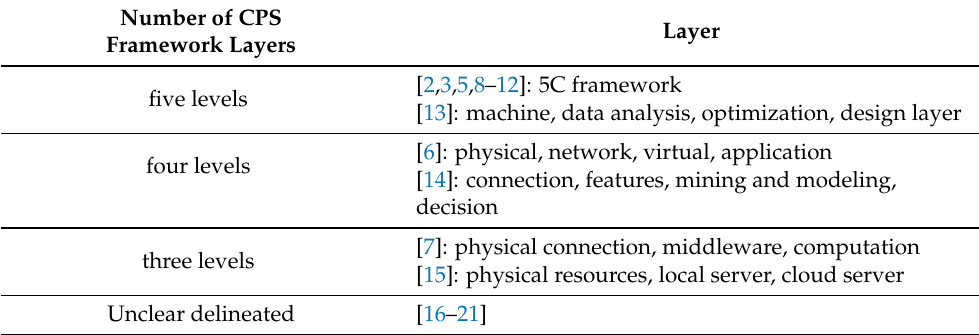
Table 1. The division of CPS layers.